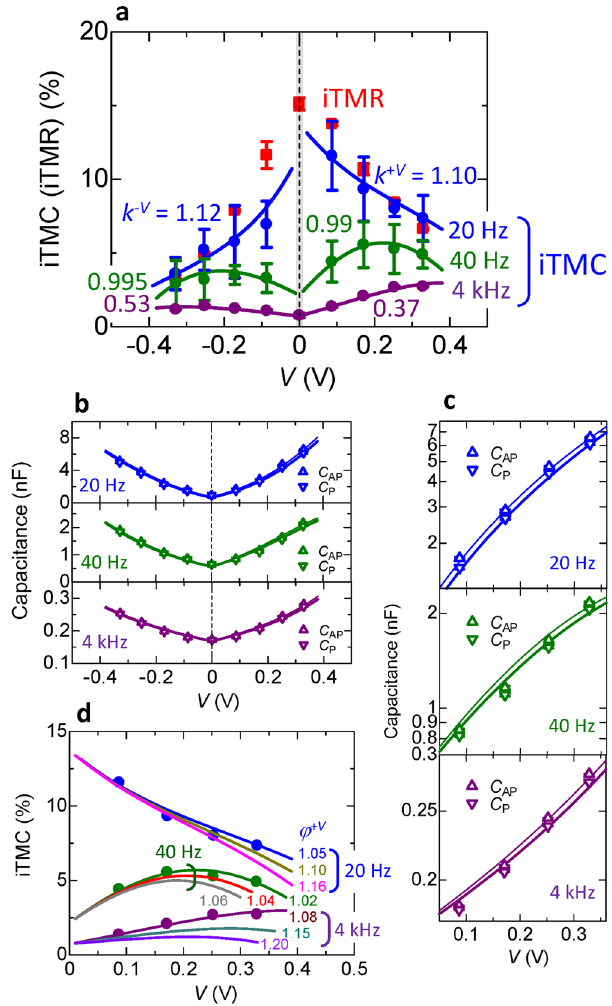
Figure 8. Bias dependence of large inverse TMC. Positive and negative bias dependence of ( a ) the iTMC, ( b ) the capacitance C P(AP) of the P(AP) configuration and ( c ) the log-scaled C P(AP) in the positive bias region at 20, 40 and 4 kHz, respectively, for sample C. The solid lines represent the fitting results calculated using the parameter, indicated in Supplementary Table 2. The iTMR at 20 Hz is also shown. ( d ) Positive bias dependence of the calculated iTMC in varying ϕ + V , which is the ratio α α µ µ / , described in equation (3). The best fit to P AP experimental results is obtained by setting ϕ + V = 1.05, 1.02 and 1.08 at 20, 40 and 4 kHz,